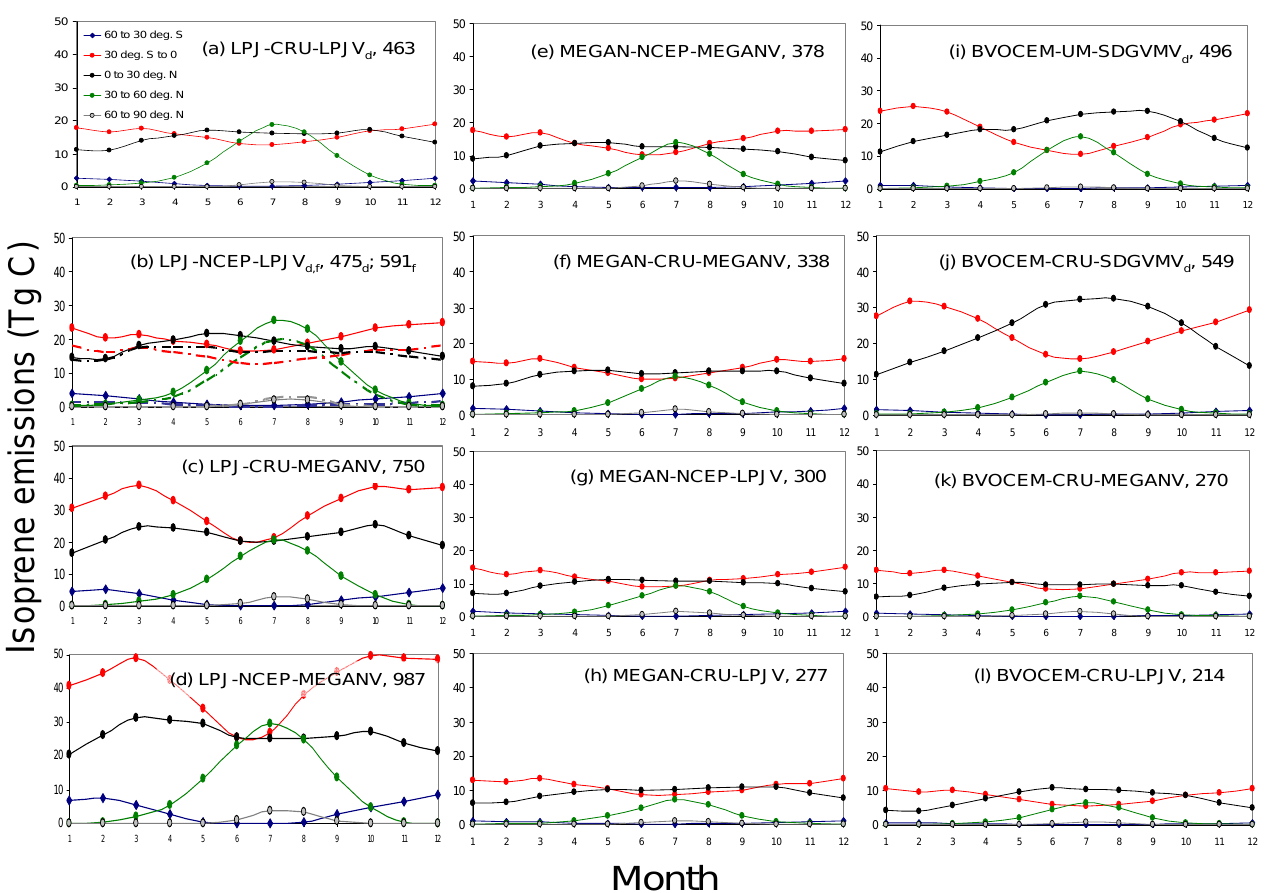
Fig. 2. Seasonal isoprene emissions from the different model experiments, separated by latitudinal bands (deg.: degrees). The naming convention for each simulation was “Model-climate-vegetation” (see Table 1). Panels (a) , (e) and (i) are equivalent to the models published and evaluated standard settings (e.g., Arneth et al., 2007a, Guenther et al., 2006, Lathi`ere et al., 2010). Shown are averages for the period 1981–2002, except for panel (i) as the UM climate was only available for one year. Numbers in the top right corner of each panel are annual sums, in TgCa − 1 . In panels (a, b) and (i,j) , For the two DGVMs, subscribed “d” or “f” indicates whether the dynamic vegetation core in the model responds to the climate in the given simulation (dash-dotted line in panel (b) ), or whether vegetation prescribed from the standard run was used (straight line in panel (b)